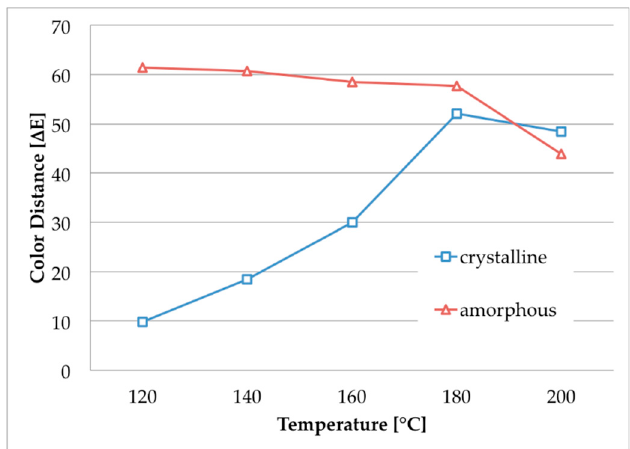
Figure 4. Color distances of amorphous and crystalline m-aramid fabrics after dyeing with Doracryl Red in EMIM-EtSO 4 (temperature range 120–200 °C, for pictures see Figure 3, row 1 and 2).